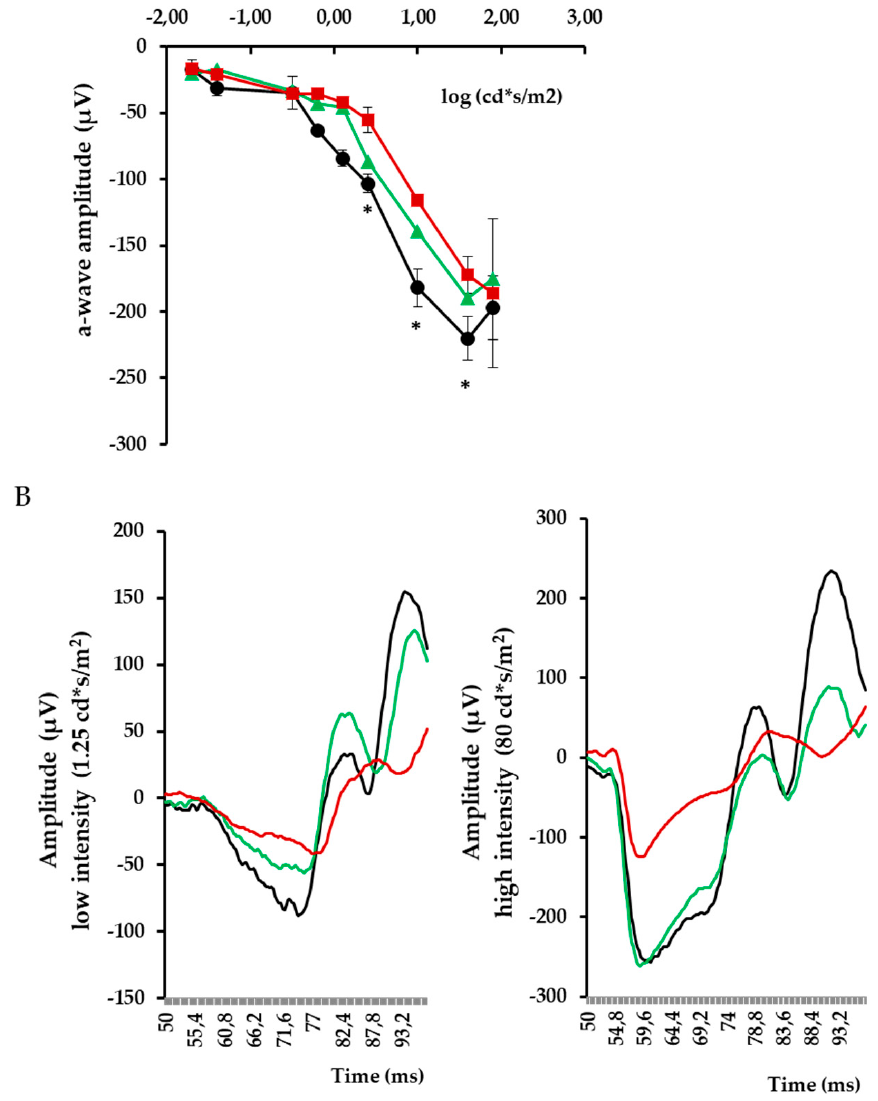
Figure 7. ( A ) Quantitative analyses of a wave amplitude in db/db mice treated with vehicle (red), db/db mice treated with sitagliptin (green), and non-diabetic mice (black). * p < 0.05 vs. db/db mice treated with vehicle. ( B ) Electroretinogram traces in response to low and high stimulus intensities in a representative non-diabetic mouse (black), a db/db mouse treated with vehicle (red), and a db/db mouse treated with sitagliptin (green).